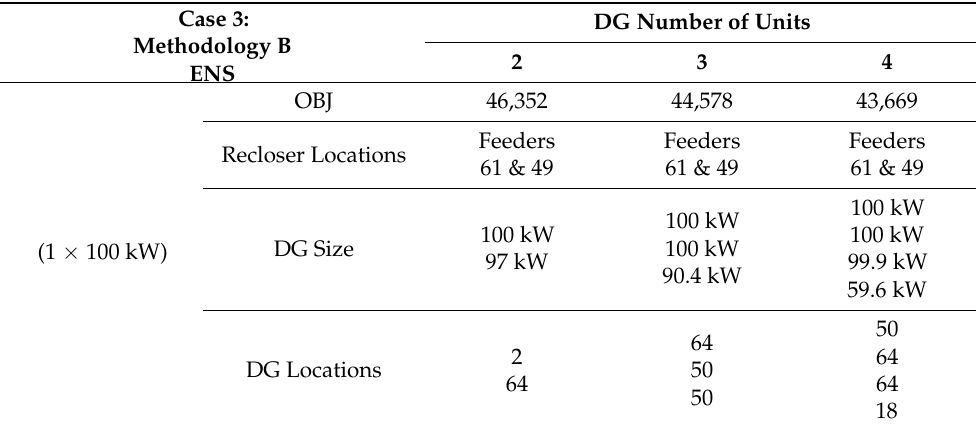
Table 6. System indices indicating the effect of spreading the number of DG units. Case